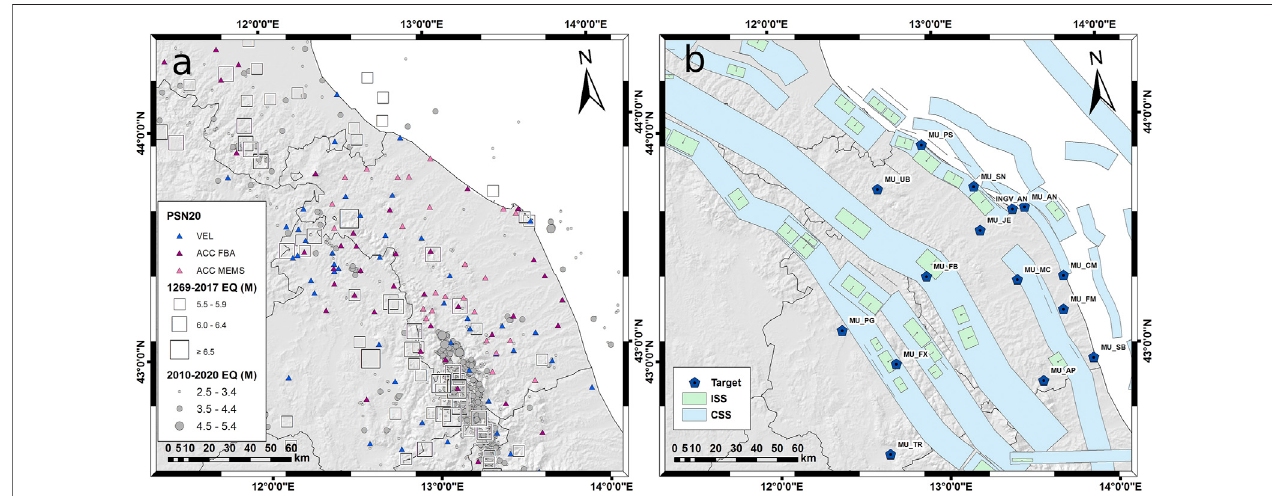
FIGURE1| Seismicity,seismicnetwork,differentfaultzones,andselectedtargetsofthestudyarea.a)PSN20:PermanentSeismicNetworkintheyear2020.Blue triangles: velocimetric sensors. Purple triangles: FBA high performance accelerometer sensors. Pink triangles: MEMS accelerometer. Black squares: 1219 – 2019 EQ, moderate to strong earthquakes (M ≥ 5.5) extracted from CPTI15 database (Rovida et al., 2021). Grey circles: earthquakes recorded by the seismic network from 2010 to 2020 in the magnitude range 2.5 ≤ M ≤ 5.4. b) Pentagon: Targets. ISS: individual seismogenic source. CSS: composite seismogenic source (see text for explanation, DISS Working Group (2018)).